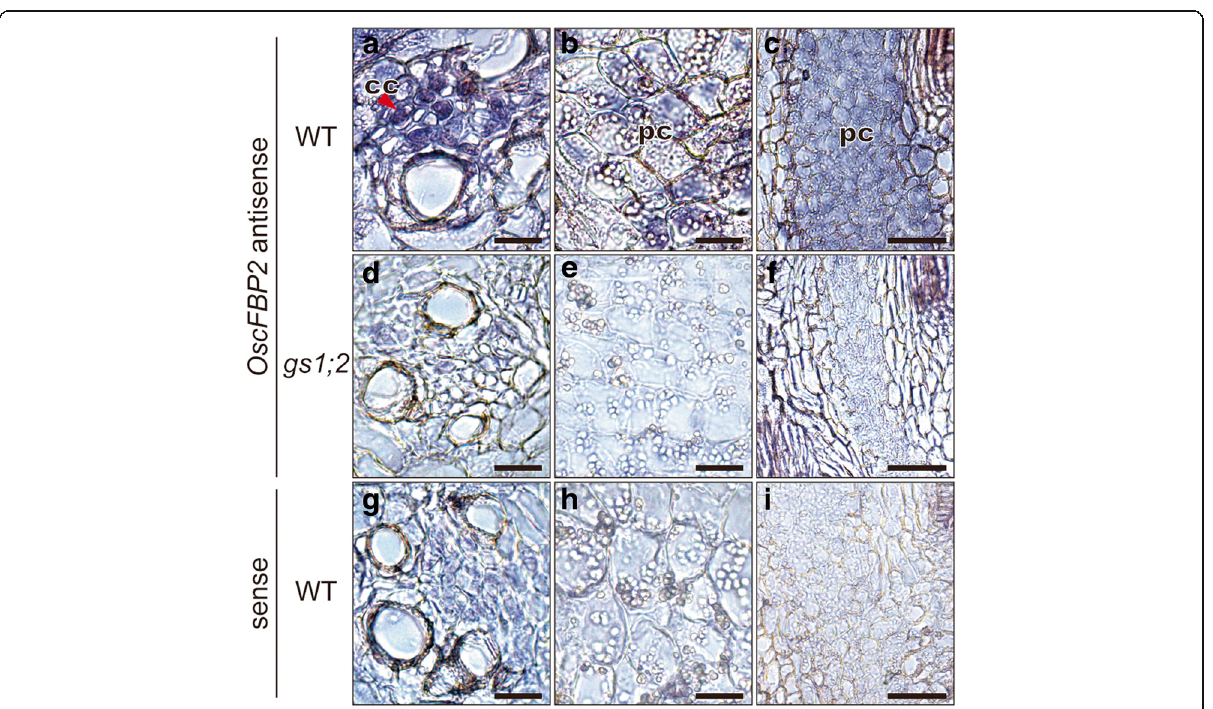
Fig. 4 In situ hybridization of OscFBP2 in the basal portions of the shoots. Longitudinal sections of the basal portions of the shoots were prepared from wild-type (WT) ( a-c , g-i ) and gs1;2 mutants ( gs1;2 ) ( d-f ) rice grown hydroponically in the presence of 1 mM NH 4 Cl until the fourth leaf stage. The antisense probe for OscFBP2 transcript was hybridized using longitudinal sections of the shoot basal portions of wild-type ( a-c ) and gs1;2 ( d-f ) rice seedlings. The sense probe for OscFBP2 transcript was hybridized using sections of the shoot basal portions of wild-type ( g-i ) rice seedlings as a negative control. The phloem companion cells of the nodal vascular anastomoses ( a, d, g ), the internodal parenchyma cells ( b, e, h ), and the leaf sheath ( c, f, i ) are shown. The red arrowhead in ( a ) indicates the hybridization signal of the OscFBP2 transcript in the phloem companion cells of the nodal vascular anastomoses. Abbreviations: cc, companion cell; pc, parenchyma cell. Scale bars: 20 μ m ( a, b, d, e, g, h ) and 50 μ m ( c, f, i )